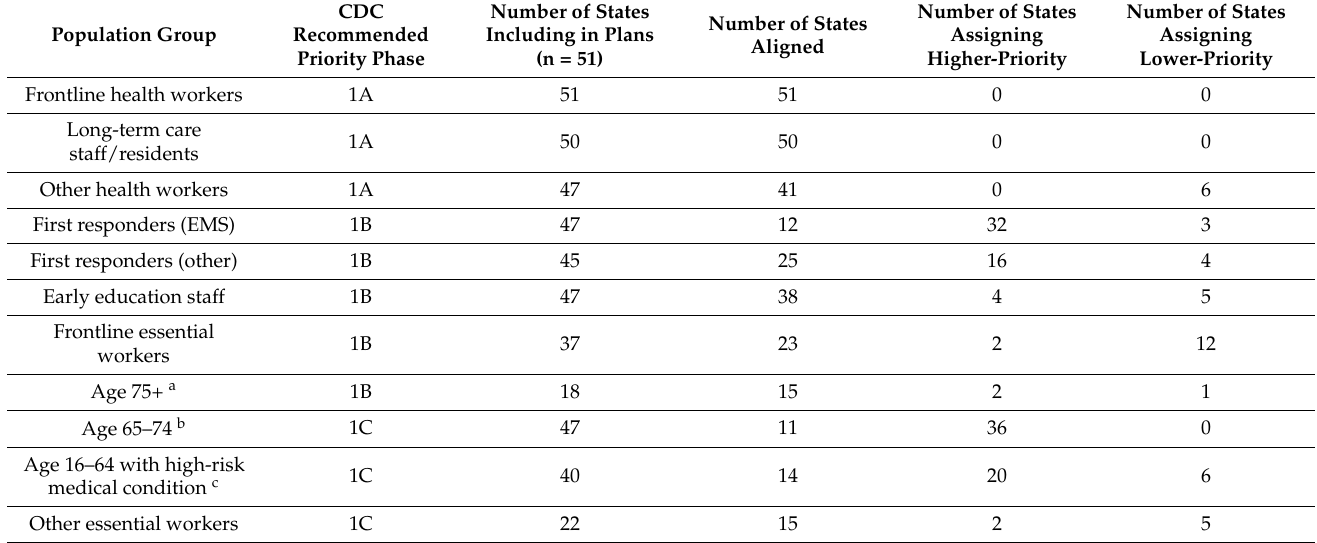
Table 2. State alignment with CDC guidance on COVID-19 vaccine prioritization.